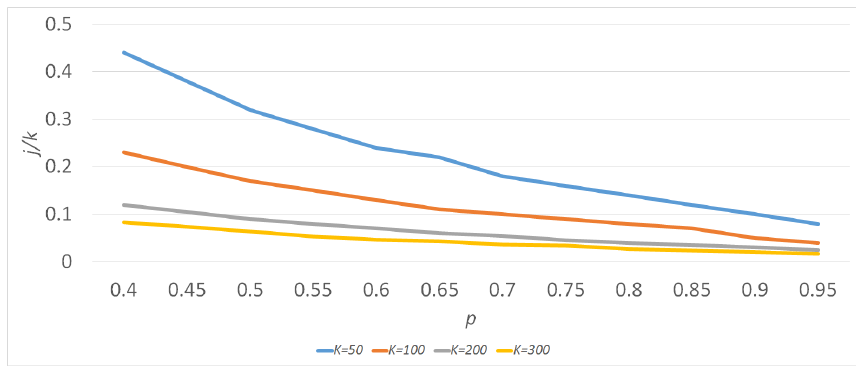
Figure 8. Ratio j